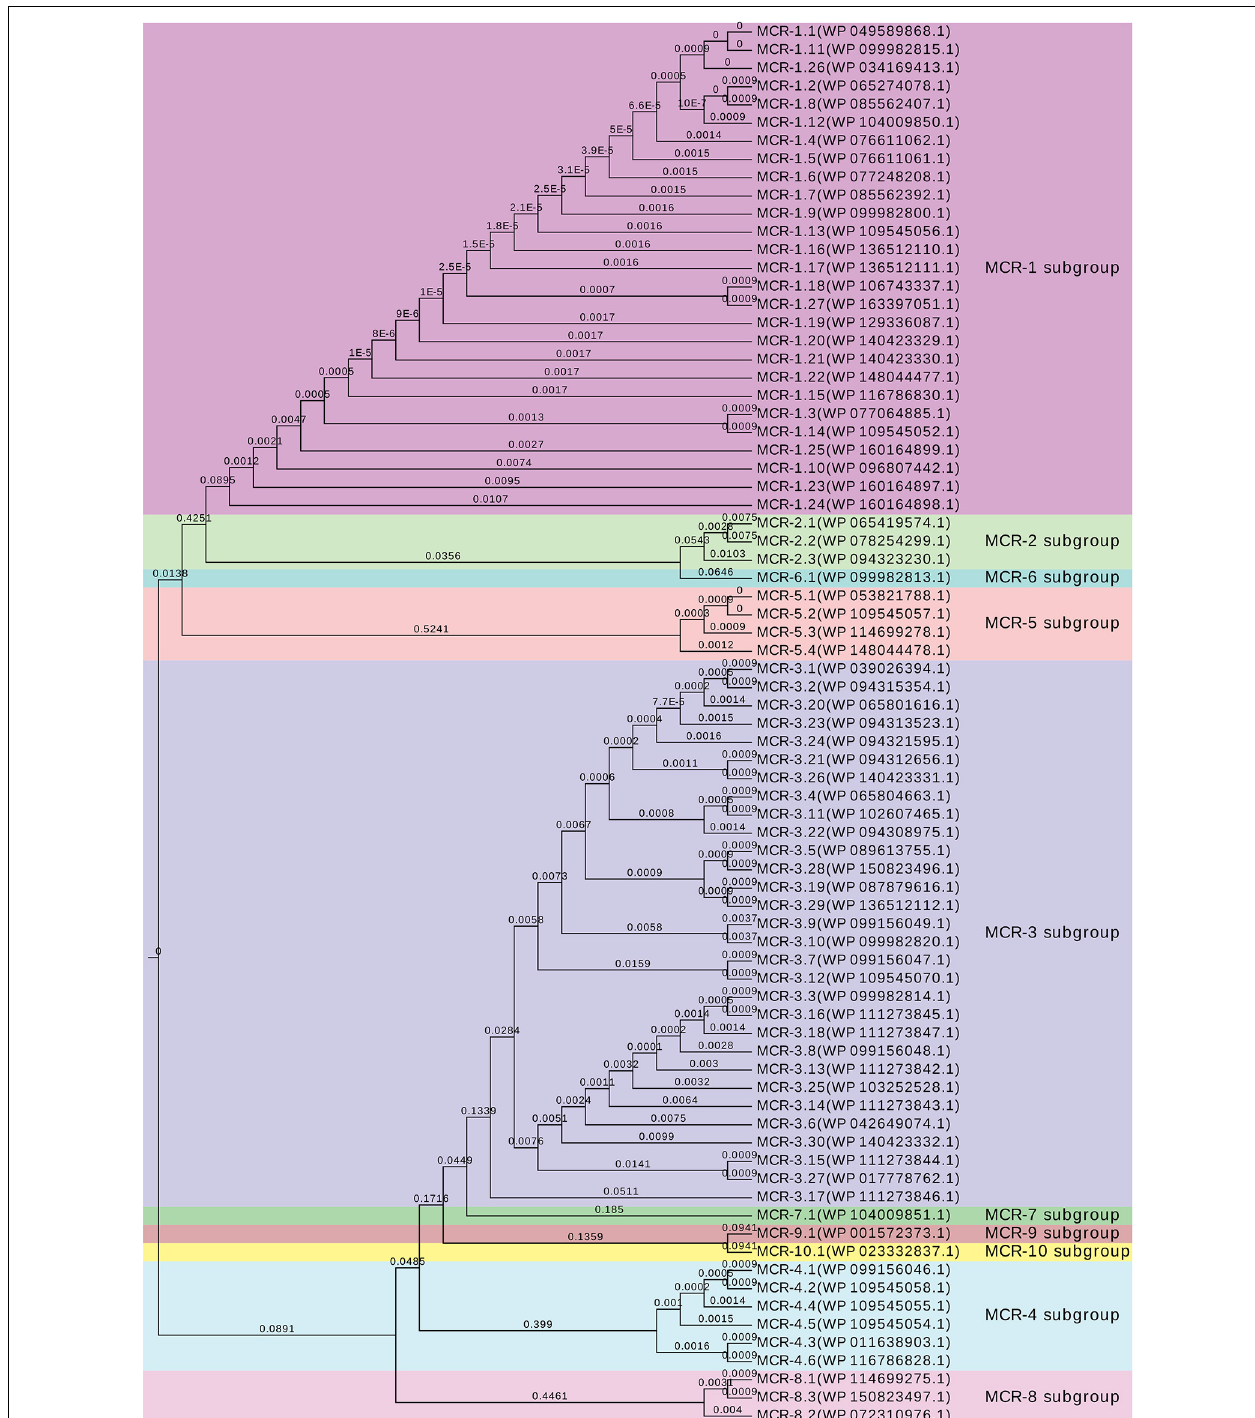
FIGURE 4 | Genetic relationships between MCR protein subgroups and related alleles. UPGMA rectangular cladogram tree of the deduced amino acid sequences of putative phosphoethanolamine transferase belonged to different subgroups was constructed using Geneious prime v2019.0.4 software with Jukes–Cantor genetic distance model, and visualized by EvolView online tool (v2.0, https://www.evolgenius.info/evolview/). NCBI accession numbers are listed following by the MCR alleles and available in GenBank.